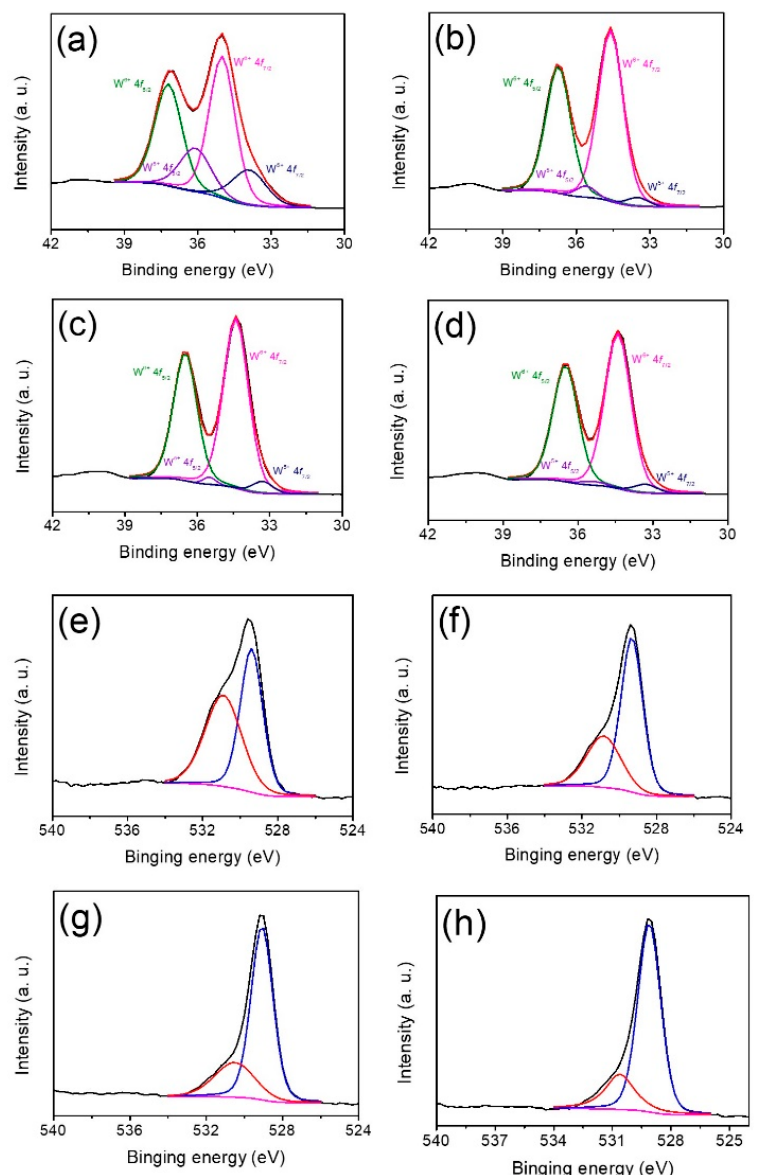
Figure 6. W4 f XPS narrow scan spectra of the WO 3 thin films with and without annealing: ( a ) as-grown, ( b ) 400 °C, ( c ) 500 °C, ( d ) 600 °C. O1 s XPS narrow scan spectra of the WO 3 thin films with and without annealing: ( e ) as-grown, ( f ) 400 °C, ( g ) 500 °C, ( h ) 600 °C.